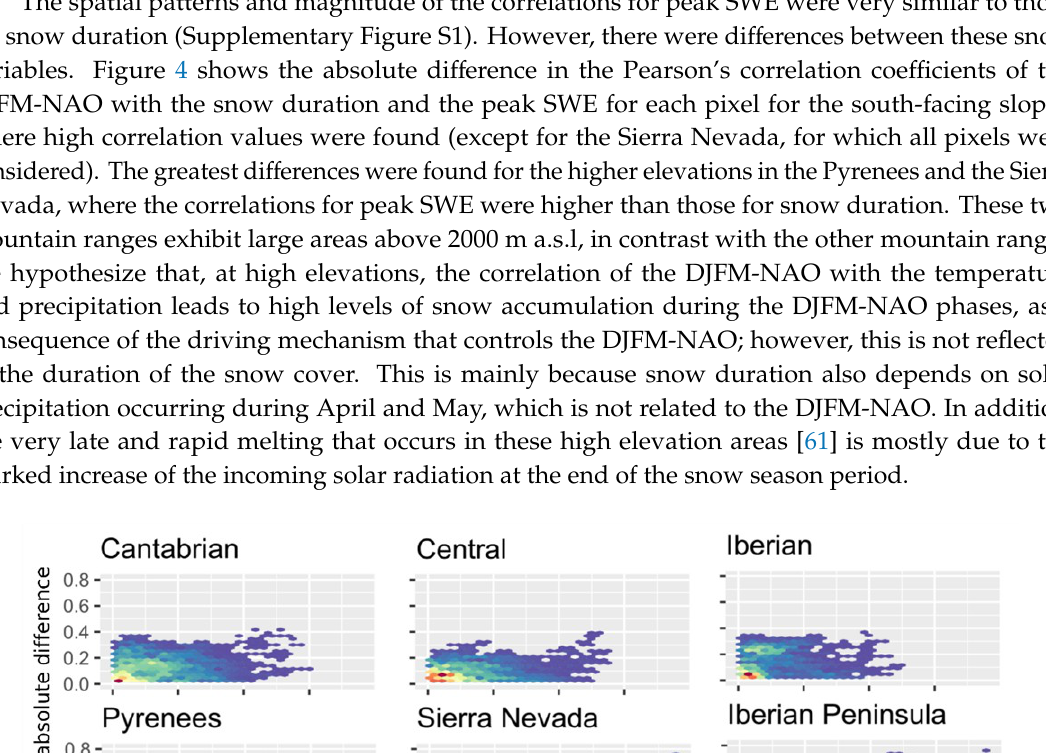
Figure 3. Pearson’s R values between the DJFM-NAO and the snowpack duration. The lines represent the boundaries of the main catchments in the Iberian Peninsula.